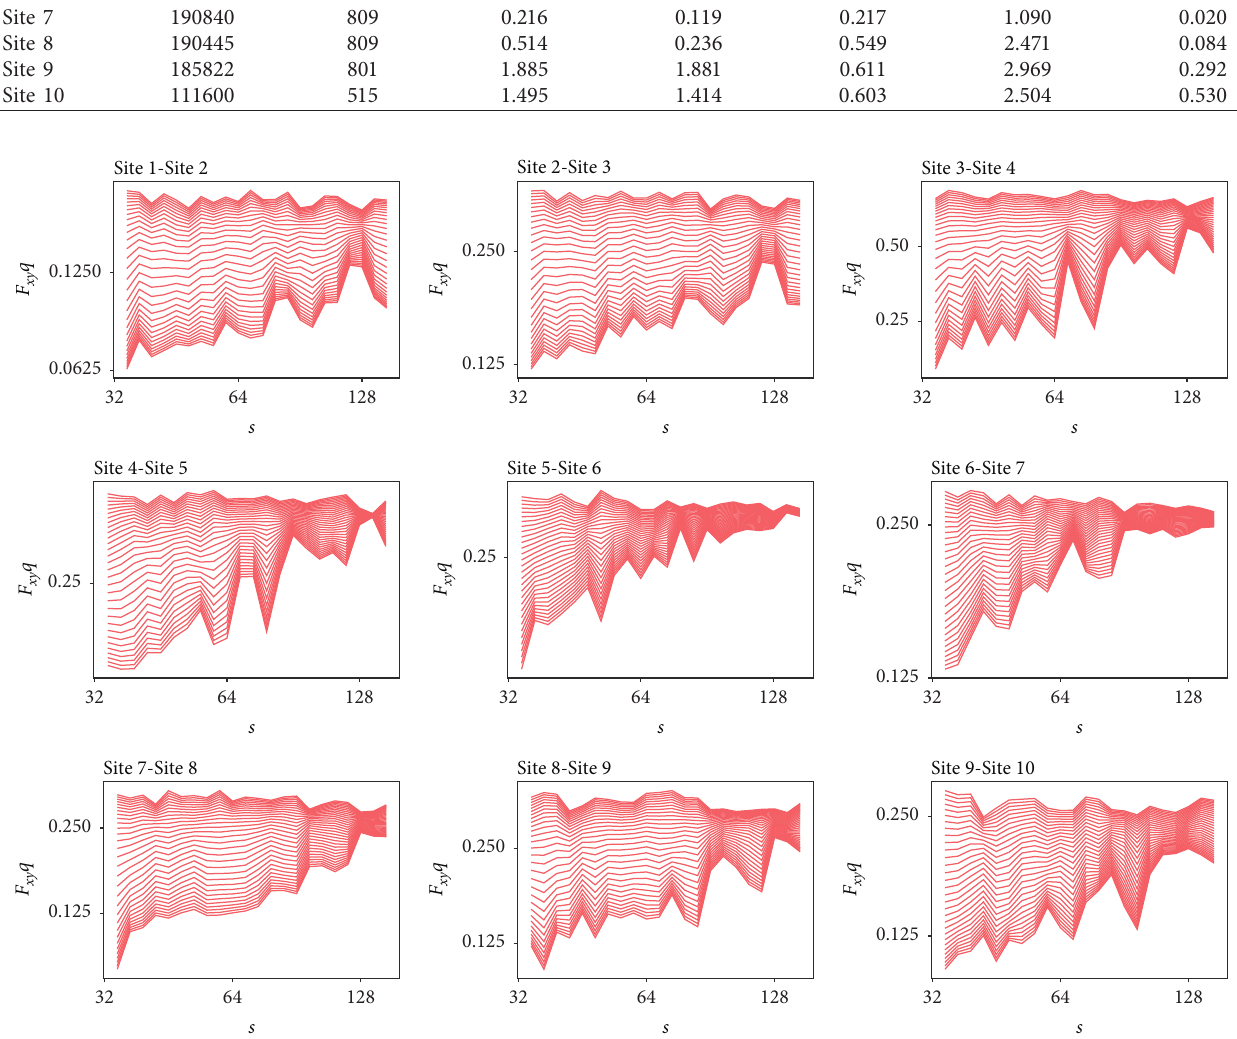
Figure 2: Log-scaling plots of F ( q,s ) versus s for two preprocessed daily average river levels at adjacent sites. The scaling range of s is XY selected from 2 5 . 1 to 2 7 . 2 . The range of q is chosen every 0.4 from − 6 to 6, which corresponds to lines from bottom to top in each